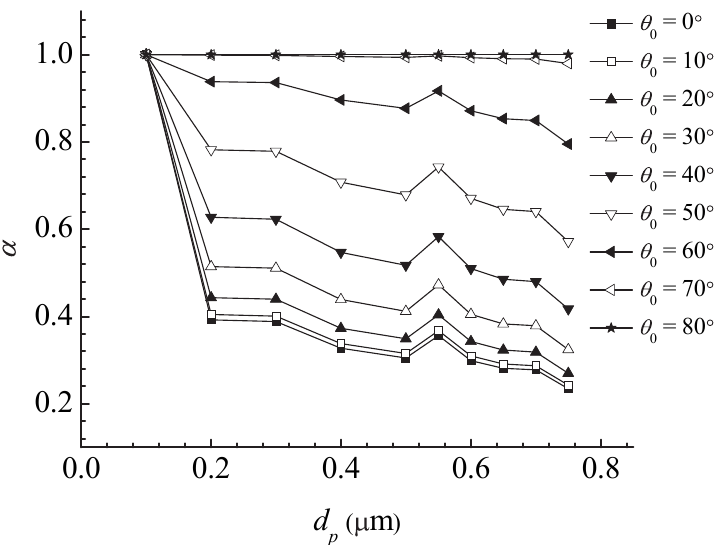
Fig. 5 Attachment efficiency for different particle diameter and initial angle of attack.